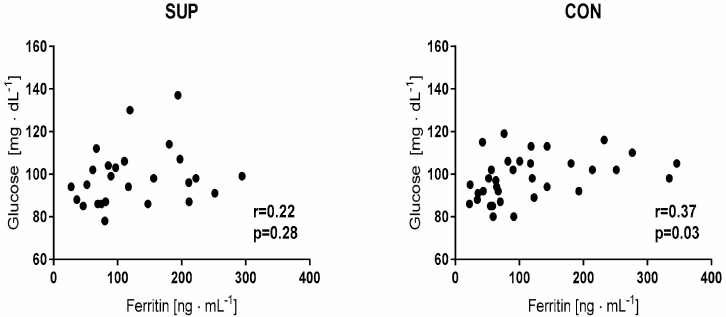
Figure 4. Correlation between glucose and ferritin levels recorded after the 12 weeks of the